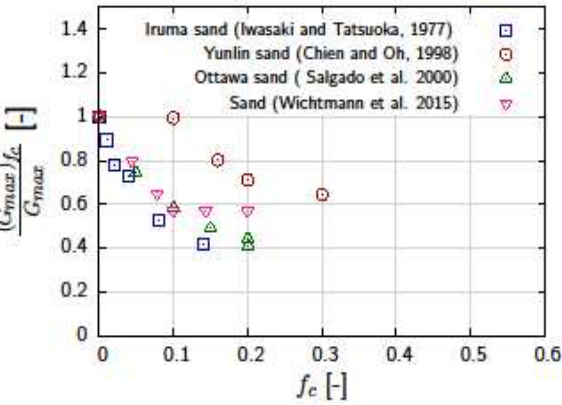
Figure 1. Reduction factor accompanying Equation (1) recommended by [12] to capture the influence of non-plastic fines on the maximum small-strain shear stiffness G max .